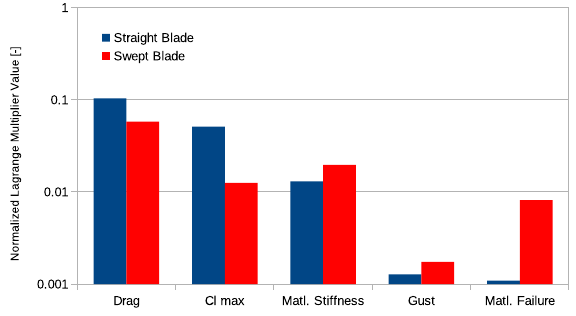
Figure 9. Lagrange multipliers due to